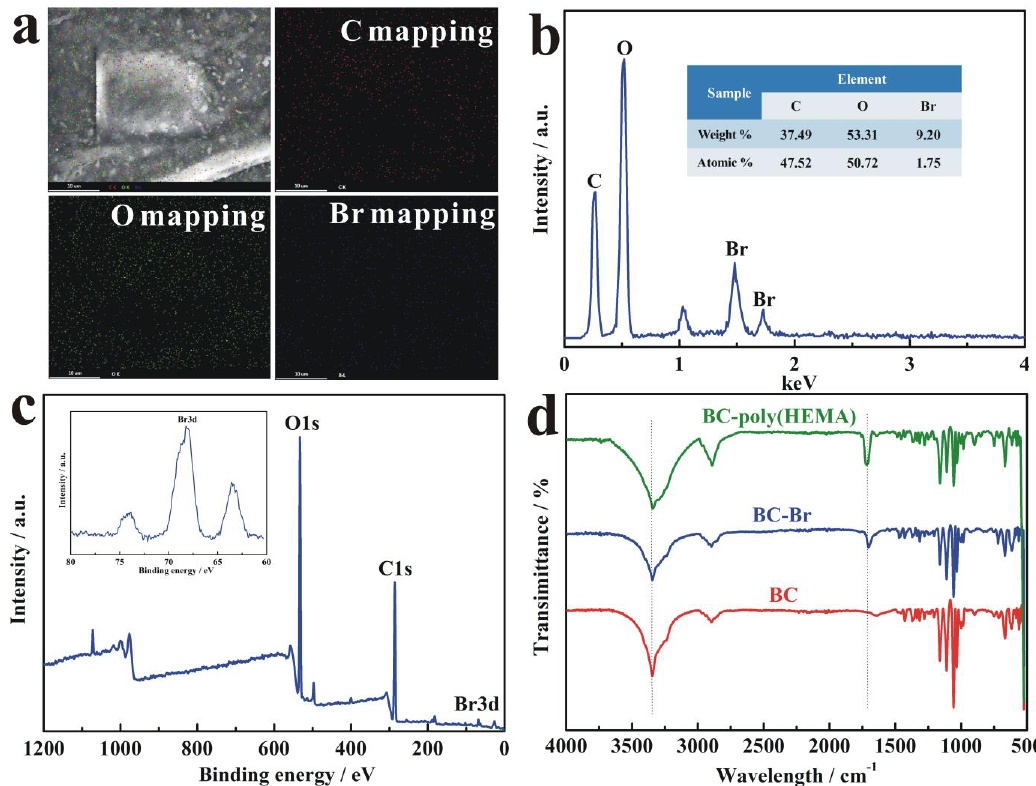
Figure 4. ( a , b ) Scanning electron microscopy–energy-dispersive X-ray spectroscopy (SEM–EDS) elemental mapping images of BC-Br; ( c ) X-ray photoelectron spectroscopy (XPS) spectrum of high-resolution C / O / Br on BC-Br; ( d ) FT-IR spectrum of BC, BC-Br, BC-poly(HEMA).